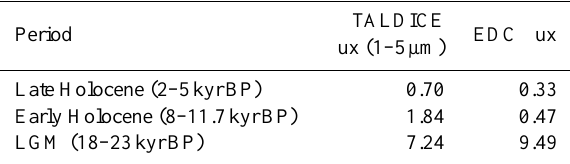
Table 1. Average dust deposition flux (mgm − 2 yr − 1 ) for TALDICE (this work) and EDC (Delmonte et al., 2004) in three different sub-periods of the temporal window analysed in the